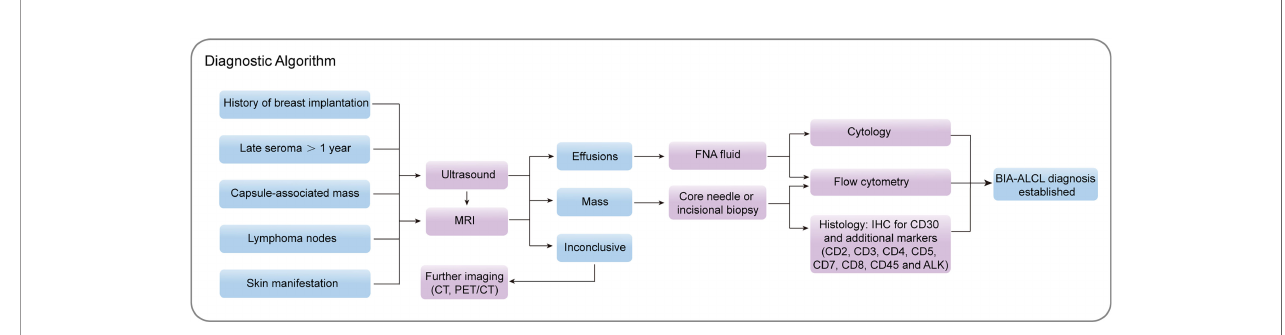
FIGURE 2 | Proposed diagnostic algorithm for BIA-ALCL. MRI, magnetic resonance imaging; CT, computed tomography; PET/CT, positron emission tomography/ computed tomography; FNA, fi ne needle aspiration; IHC, immunohistochemistry; BIA-ALCL, breast implant-associated anaplastic large cell